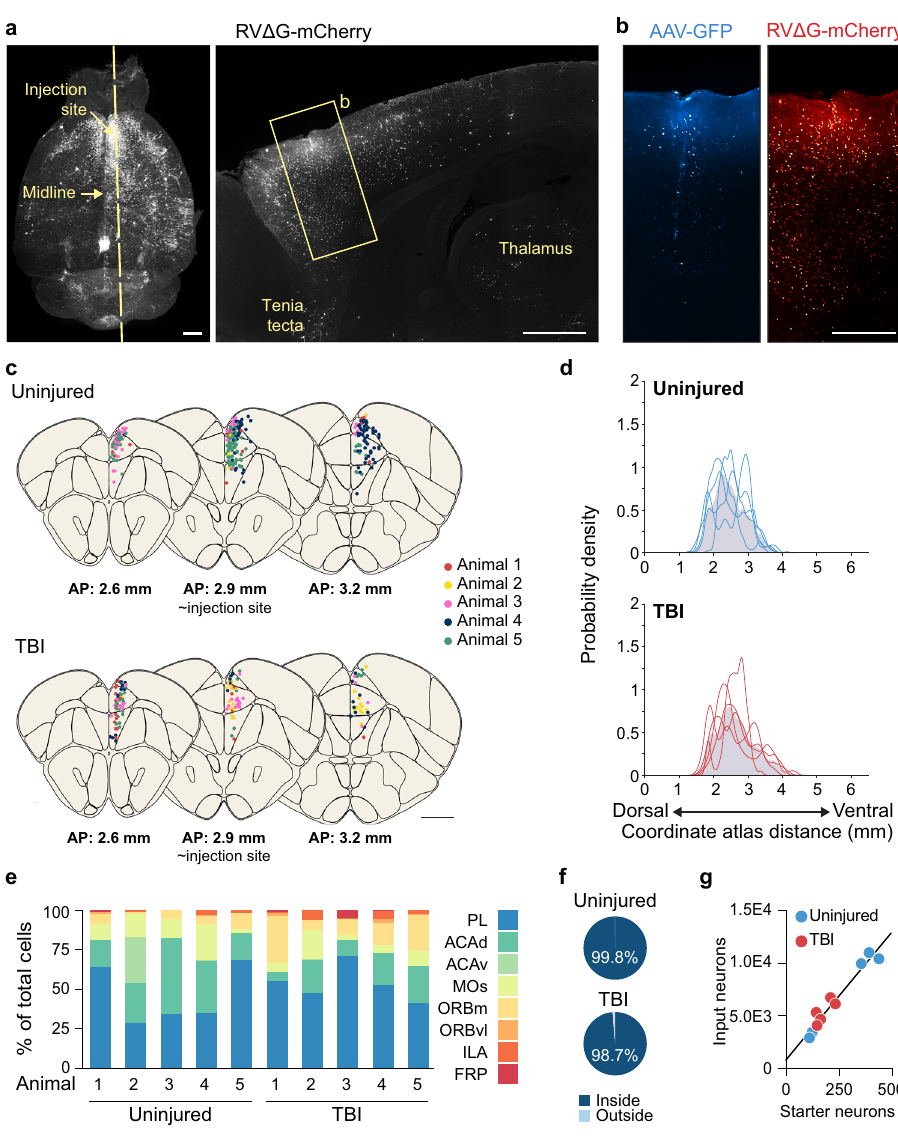
Fig. 5 Distribution of starter neurons in PFC. a Left: Whole brain cleared using iDISCO + and labeled for neurons providing input to PFC SST interneurons (white). Right: 100 μ m sagittal optical section of the same brain showing rabies-labeled input neurons at the injection site. b Boxed region shown in (a) labeled for starter cells (blue) and input neurons (red). c . Schematic coronal sections (100 μ m) showing individual starter cells registered in standardized atlas space for uninjured controls and brain injured animals. Each color corresponds to a different animal. One dot represents one neuron. n = 5 animals per group. d Gaussian kernel cell density plots of the whole-brain distribution of starter neurons along the dorsal-ventral axis. Grey shading represents the pooled population with individual lines representing each animal. e Regional distribution of starter cells in uninjured controls and brain injured animals. f Proportion of starter cells identi fi ed within PFC (PL, ACAd, ACAv, MOs, ORBm, ORBvl, ILA). g Linear regression analysis for number of starter cells and pre-synaptic input neurons ( n = 5 mice per group; R 2 = 0.95). Scale bars, 1 mm (a and c), 500 μ m (b). A list of abbreviations is provided in Supplementary Data 2. See also Supplementary Fig. 9 to 12. Source data are provided as a Source Data fi